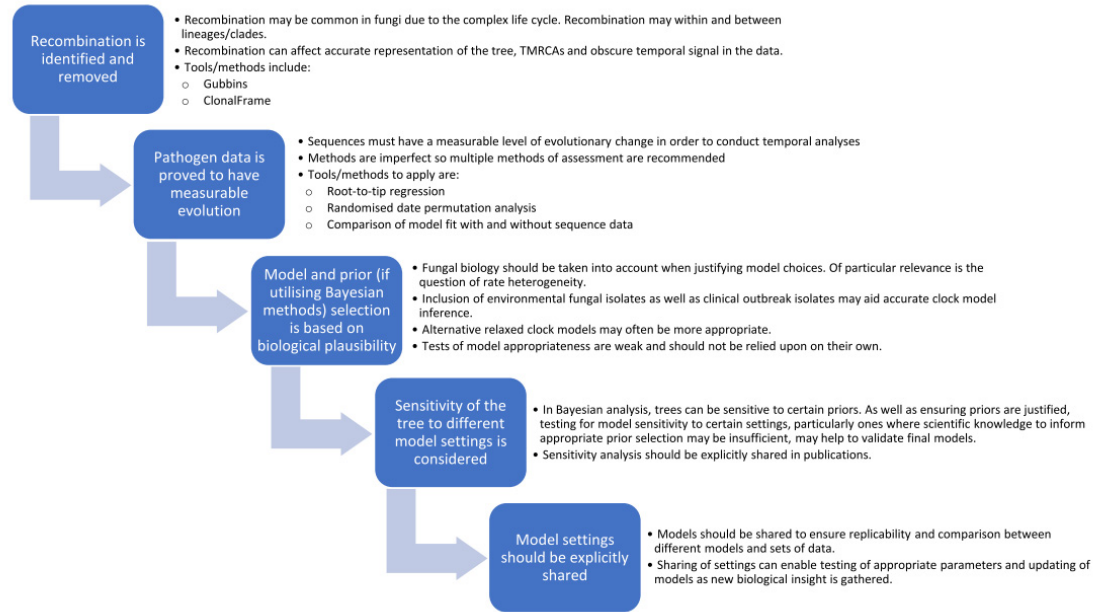
Figure 4. The fungal temporal analysis roadmap—recommendations for future fungal phylogenetic dating studies to ensure biology is taken into account and phylogenies are valid and replica- ble.